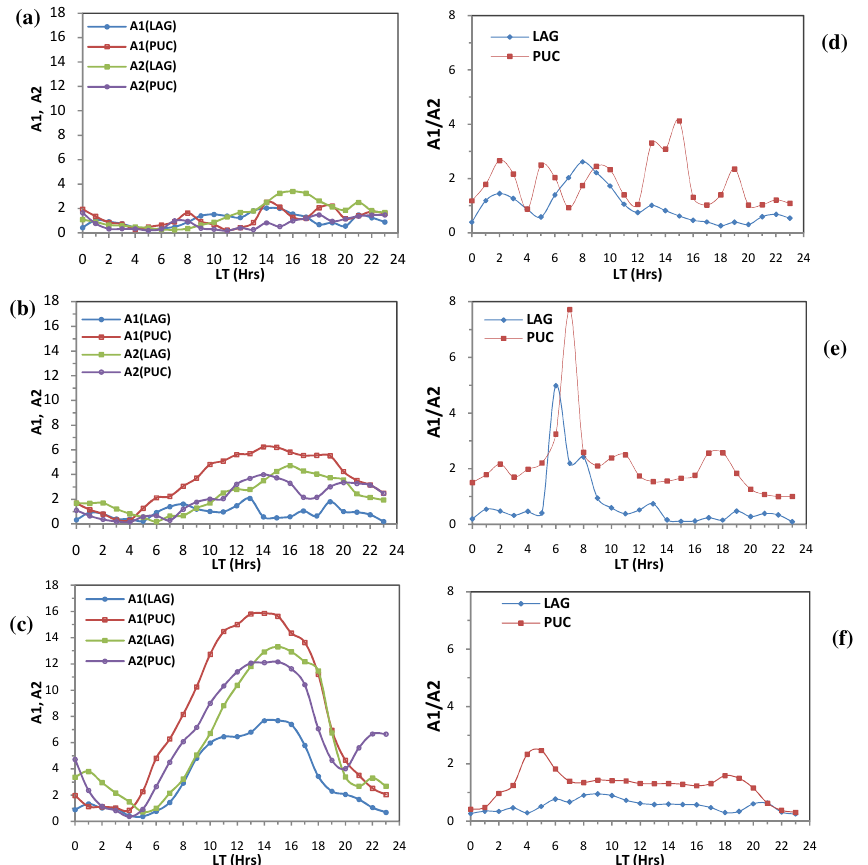
Fig. 3. Amplitudes of the annual (A1) and semiannual (A2) components over the same local time at Lagos and Pucallpa stations during (a) 2009, (b) 2010 and (c) 2011. Corresponding A1/A2 ratio at both stations during (d) 2009, (e) 2010 and (f) 2011.